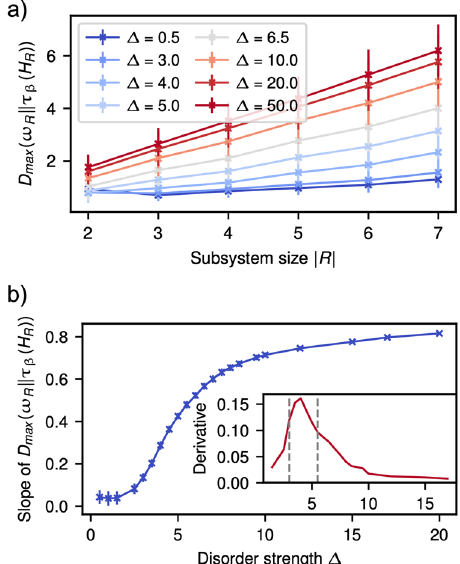
Fig. 2 Max-relative entropy for the disordered Heisenberg chain. a Max- as a function of subsystem size ∣ R ∣ for a lattice of L = 15 sites. The plots show an average of over 100 disorder realizations. The states were calculated employing exact diagonalization. For low values of disorder Δ the max-relative entropy is almost constant as ∣ R ∣ increases, while for higher values of Δ it scales linearly in ∣ R ∣ , hinting toward robustness of the MBL phase with respect to the class of interaction models we are considering. b The slope of the max-relative entropy as a function of the disorder Δ provides information on the phase transition. Indeed, we can see that this quantity abruptly increases in the proximity of the expected phase transition from the ergodic to the MBL phase. The slope is obtained by a linear fi t with error bars indicating least-squares errors. The inset shows the derivative of the slope, with the gray lines, indicate a possible transition